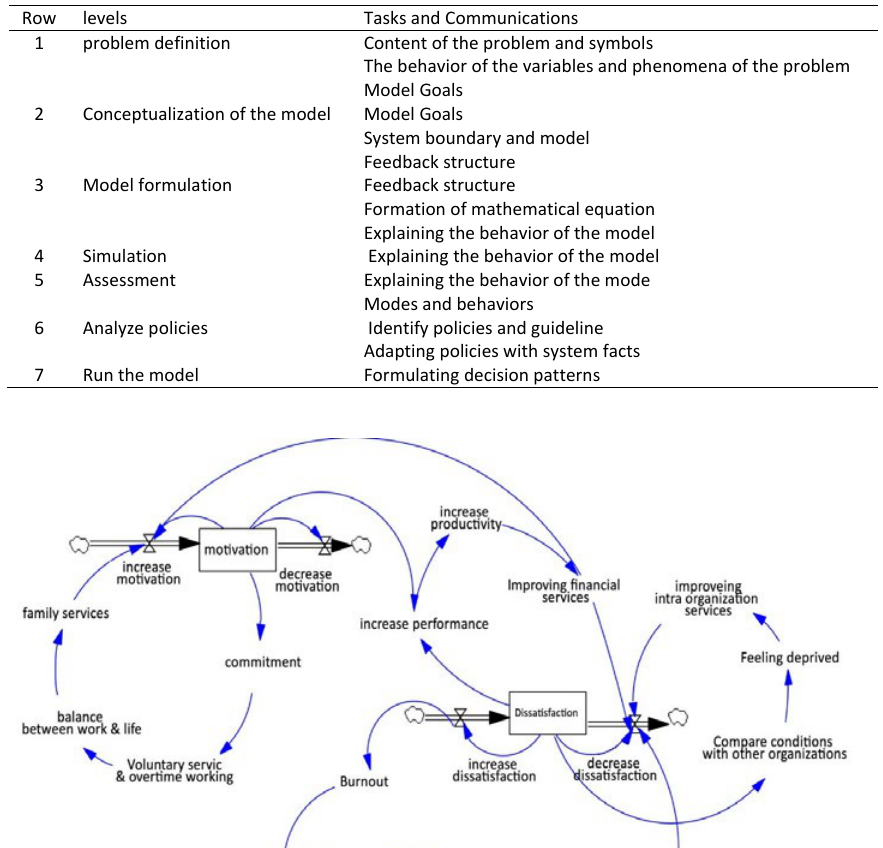
Table 1: Theoretical stages of modeling Table 1. Theoretical stages of modeling